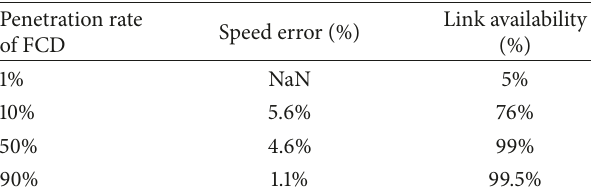
Table 1: Relation between penetration rate of FCD, speed error, and link